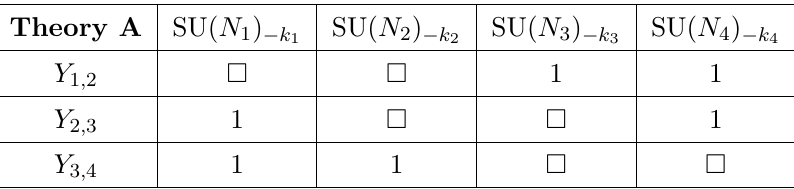
Table 2 . Charges of the bifundamental matter in our linear quivers. (cid:3) denotes the matter trans- forms in the fundamental representation of the corresponding gauge group. Four-node